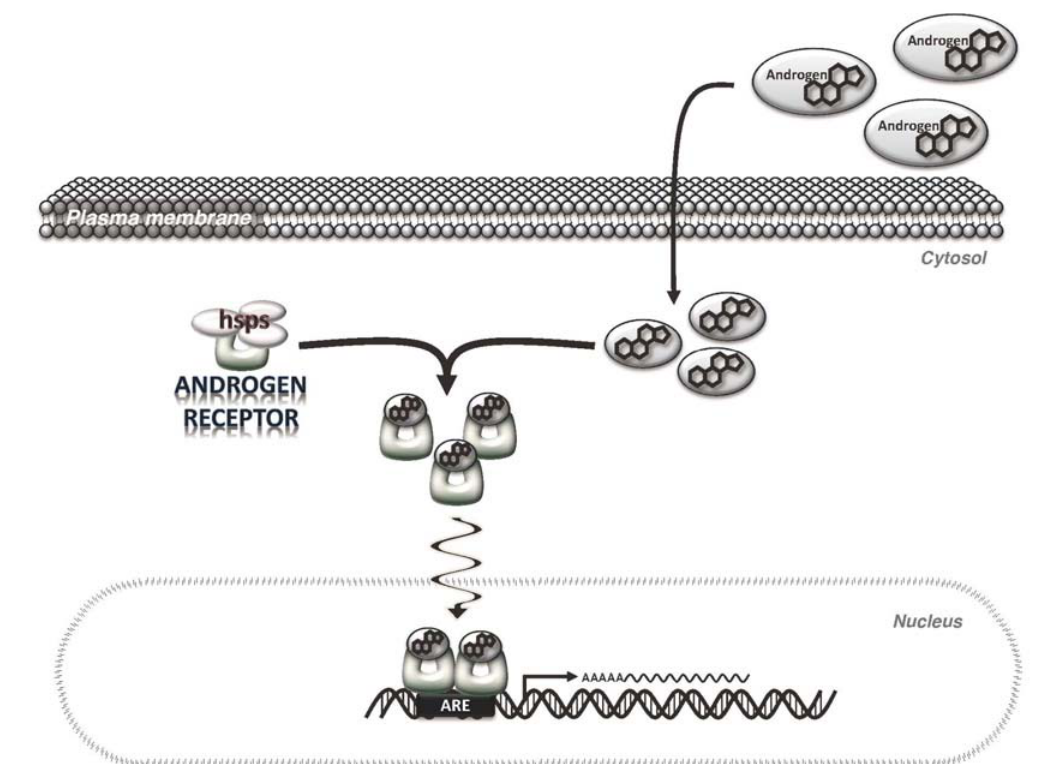
Figure 1. The androgen response in